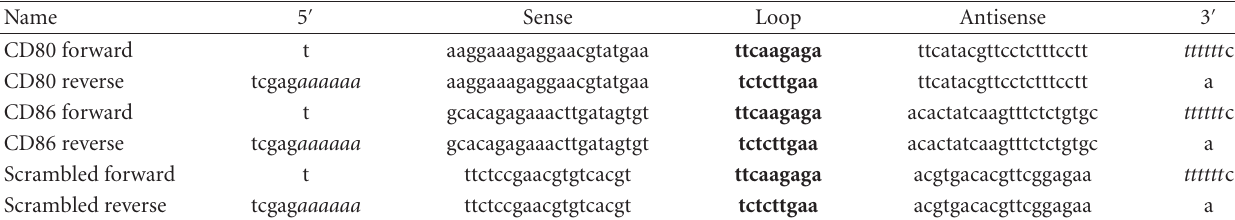
Table 1: Sequences of shRNA fragment for inserting lentivirus vector.